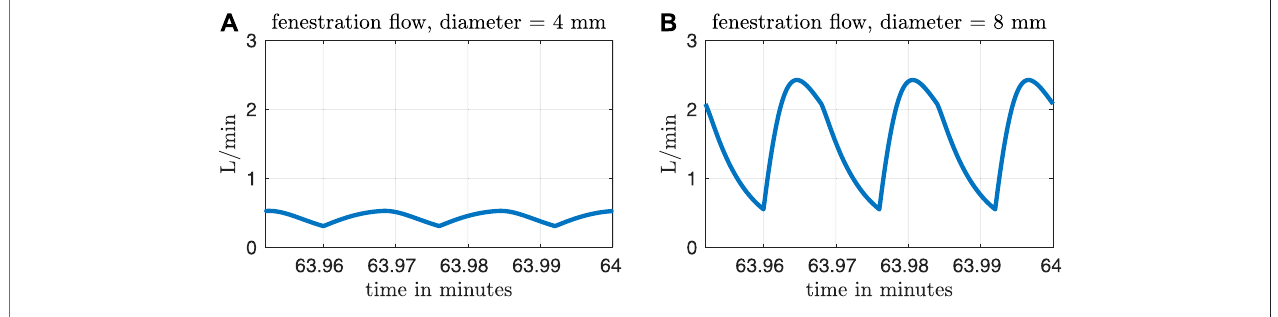
FIGURE 3 | Fenestration fl ow waveforms for two different fenestration sizes and our baseline pulmonary vascular resistance value of R p = 0.5517 mmHg min L − 1 . The waveform in panel (A) corresponds to a fenestration with diameter equal to 4 mm, and the waveform in panel (B) corresponds to a diameter of 8 mm.